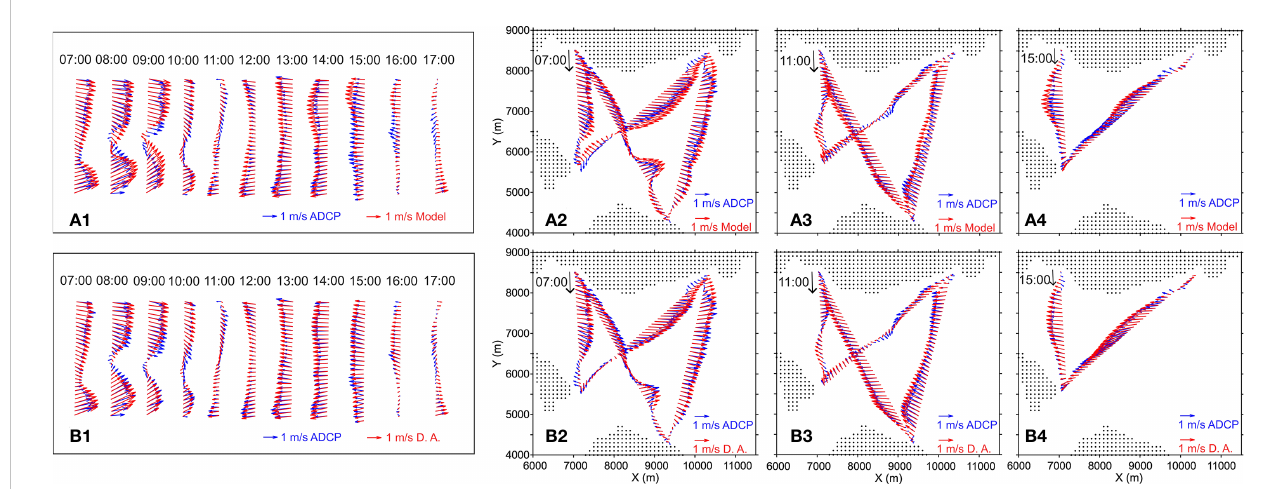
FIGURE 7 Comparison results of model prediction (panels A ; fi rst row) and data assimilation (panels B ; second row) with the ADCP results. Panels (A1, B1) are the comparisons with the ADCP results on Oct. 30 (along the dashed line in Figure 1C), and panels (A2 – A4, B2 – B4) are the comparisons with the ADCP results on Oct. 31 (along the dotted lines in Figure 1C). The data assimilation result is obtained from case 3 with 98